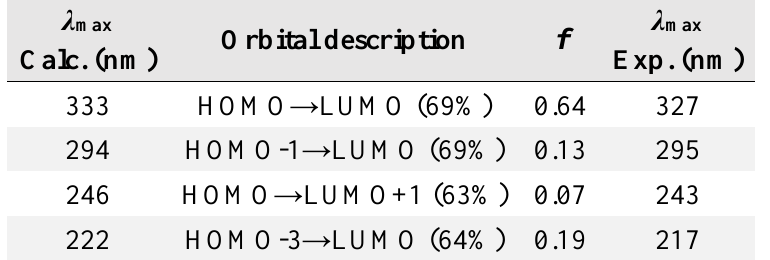
Table 3. Results of the TDDFT/B3LYP-D3 calculations. λ denotes experimental (W ANG et al. , max 2004) and calculated transition wavelengths, whereas f stands for oscillator strengths. Orbital description points out pairs of MOs involved in electronic